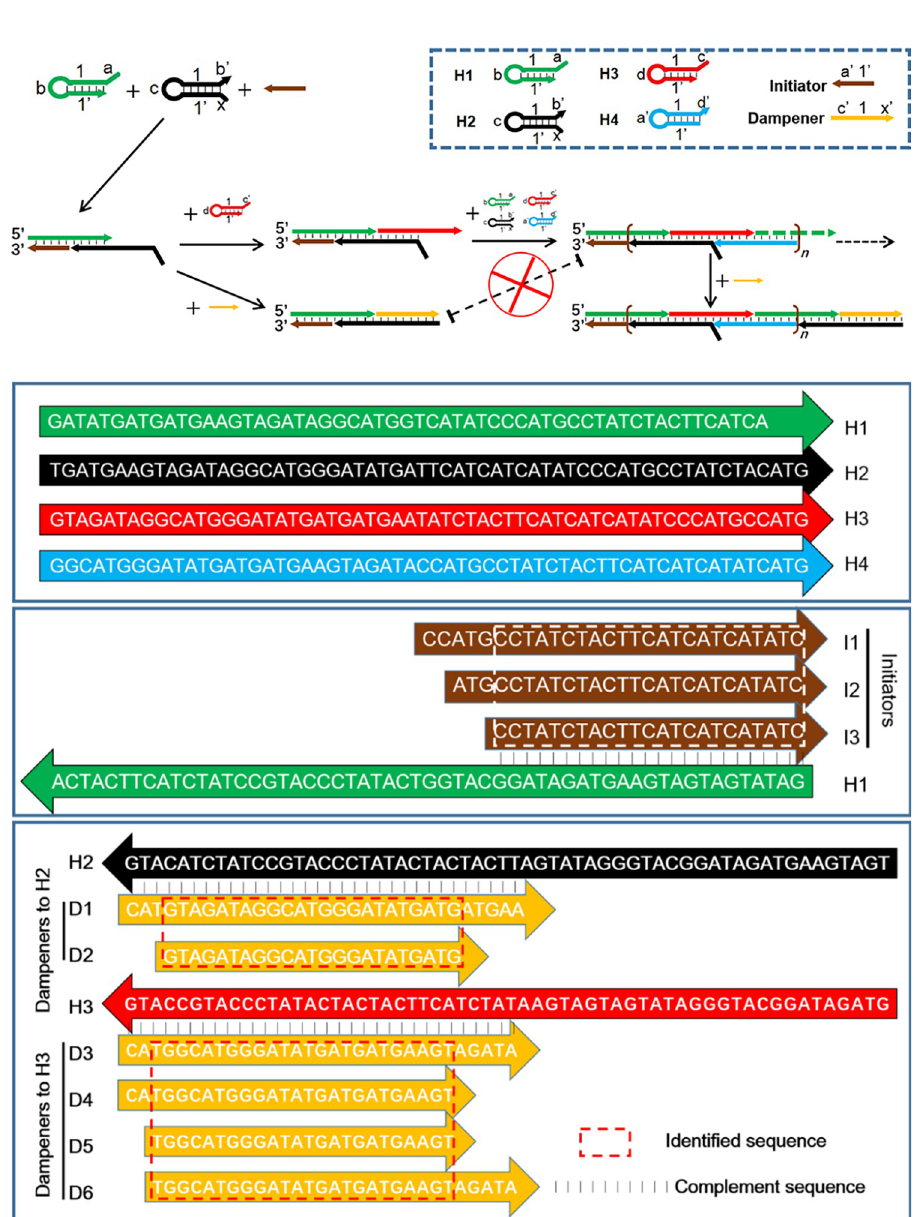
The hairpins were designed with a 6 nt toehold region, 12–18 nt stem, and 6 nt loop [38,39] to ensure a low background and a rapid hybridization rate. To select the most effective damp- ener, a series of DNA dampeners of different lengths were designed based on the template (Fig